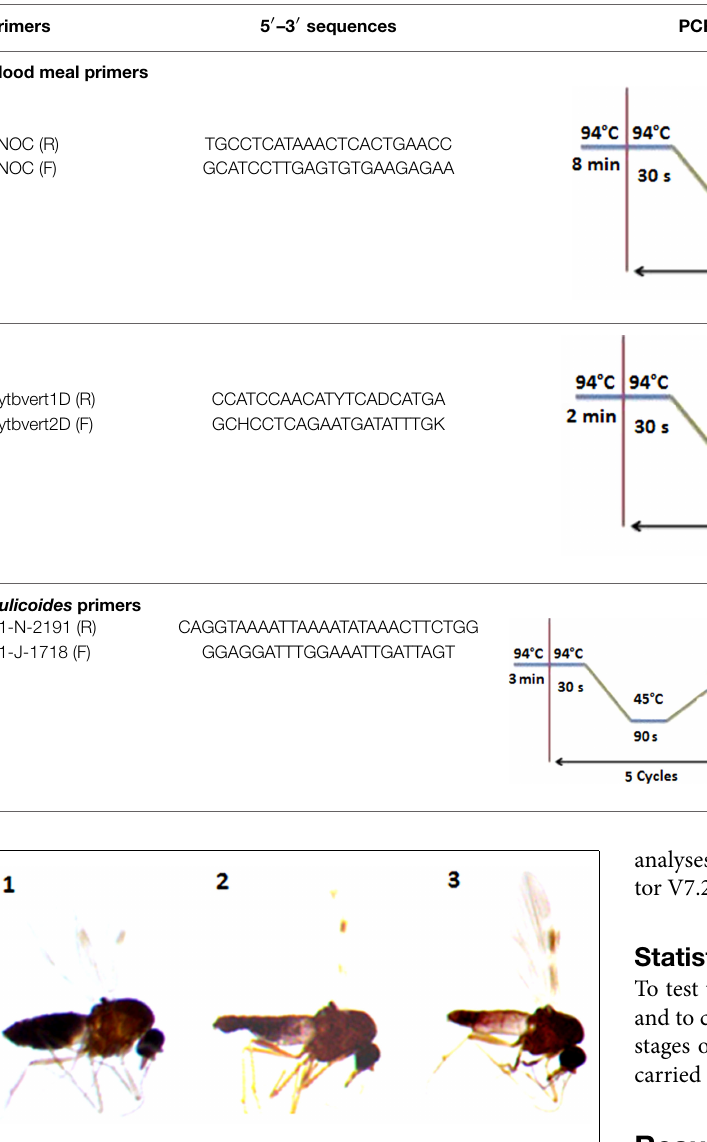
FIGURE 1 | Culicoides females with different stages of blood meal digestion . (1) Fully engorged females; (2) abdomen showing advanced signs of digestion; (3) abdomen showing any remainder of blood in their